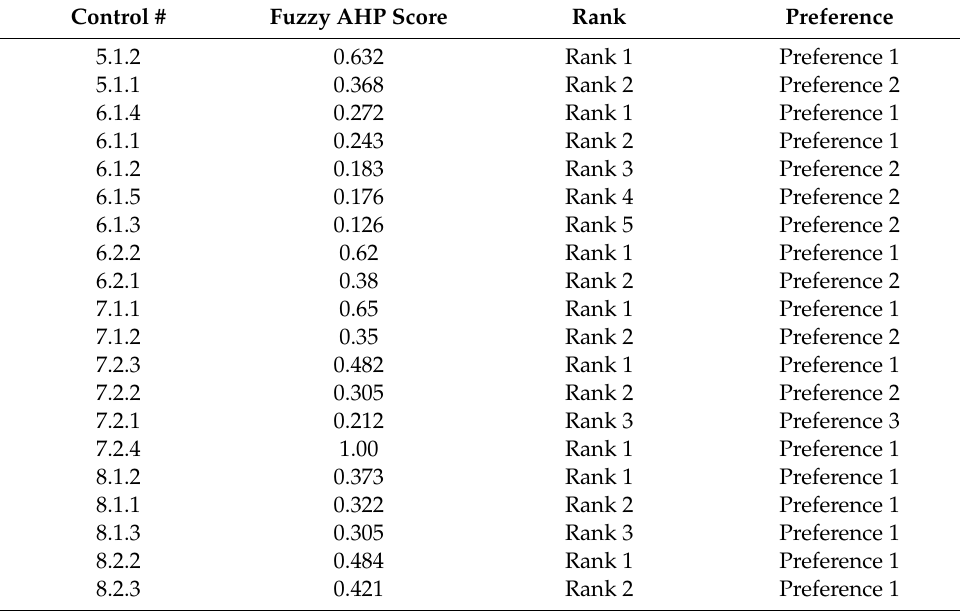
Table 22. Ranked ISO / IEC 27002:2013 information security controls. Control # Fuzzy AHP